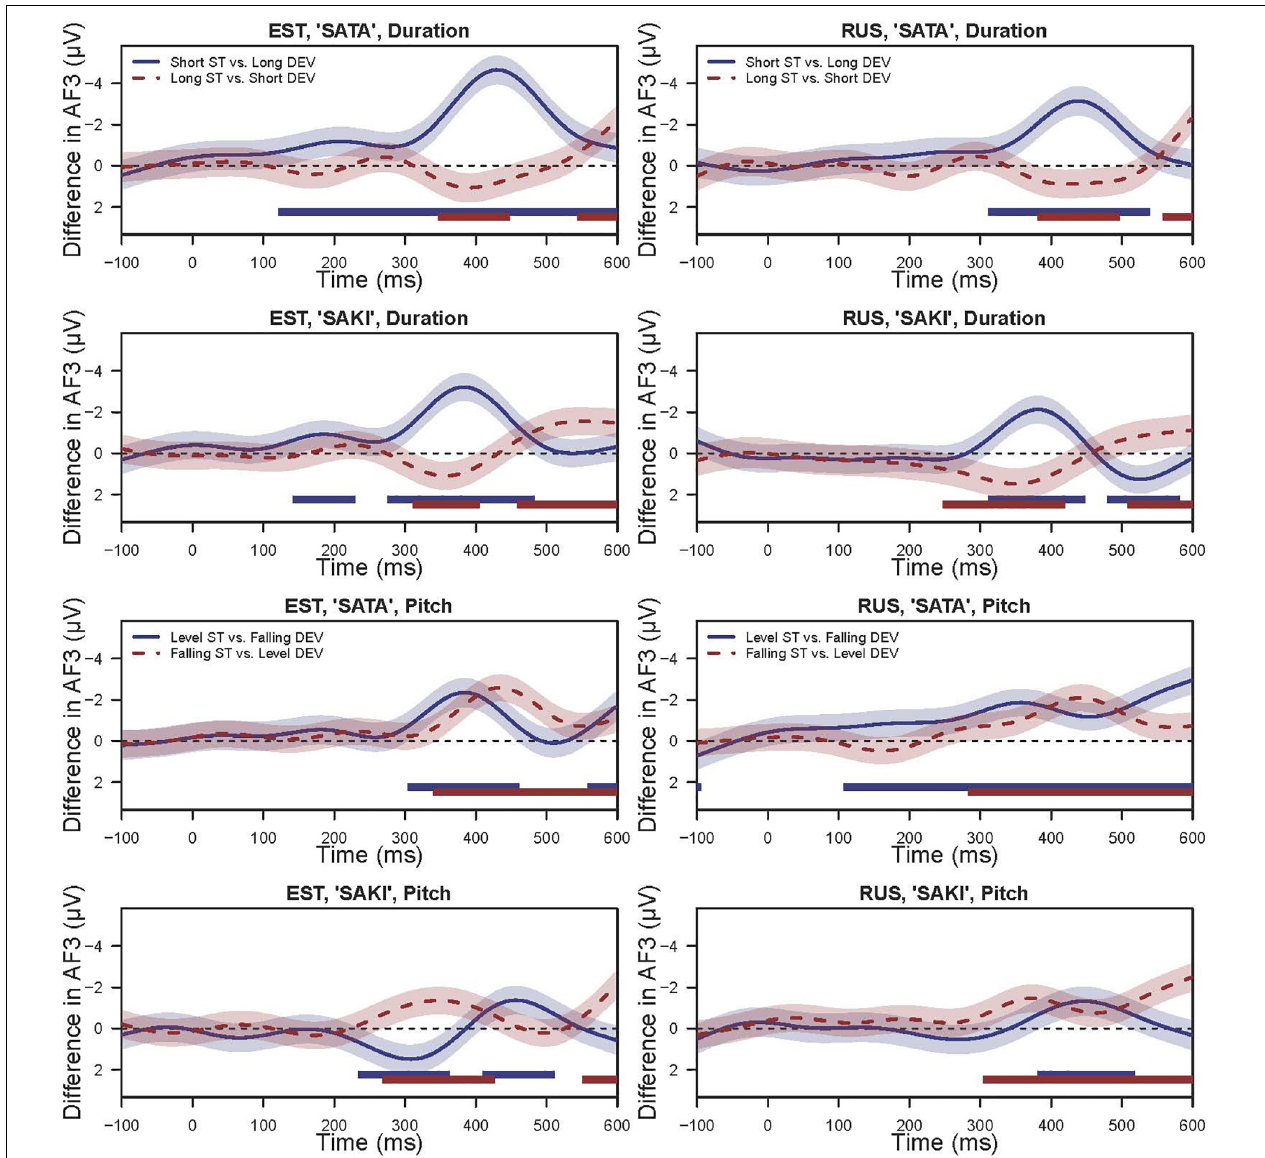
FIGURE 6 | The difference (MMN) between Deviant vs. Standard indicating (a)symmetrical processing of duration (‘Short ST-Long DEV’ vs. ‘Long ST-Short DEV’) and pitch (‘Level ST-Falling DEV’ vs. ‘Falling ST-Level DEV’) within the language groups (Estonian, EST and Russian, RUS) estimated from GAMMs. Shaded area is 95% Confidence Intervals for the difference (MMN). The bold straight lines below the curves show the range where the difference is significantly different from zero. Time point 0 indicates the beginning of the initial consonant